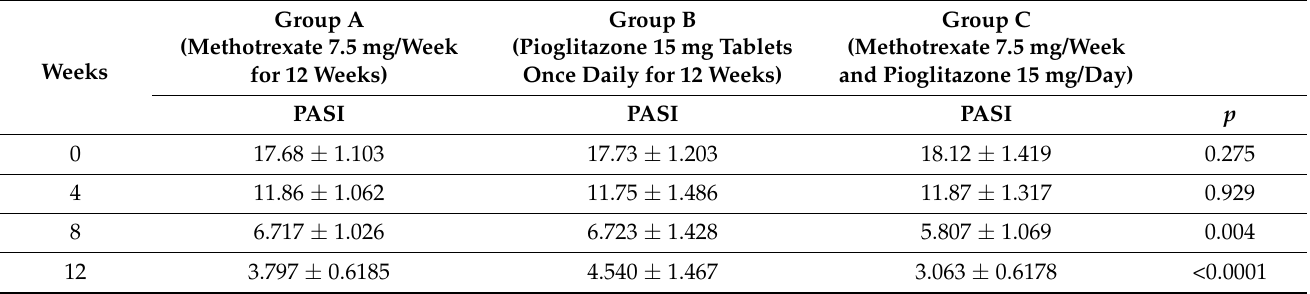
Table 10. Results of treatment, measured by PASI, with statins reported by Abidi et al. [27].